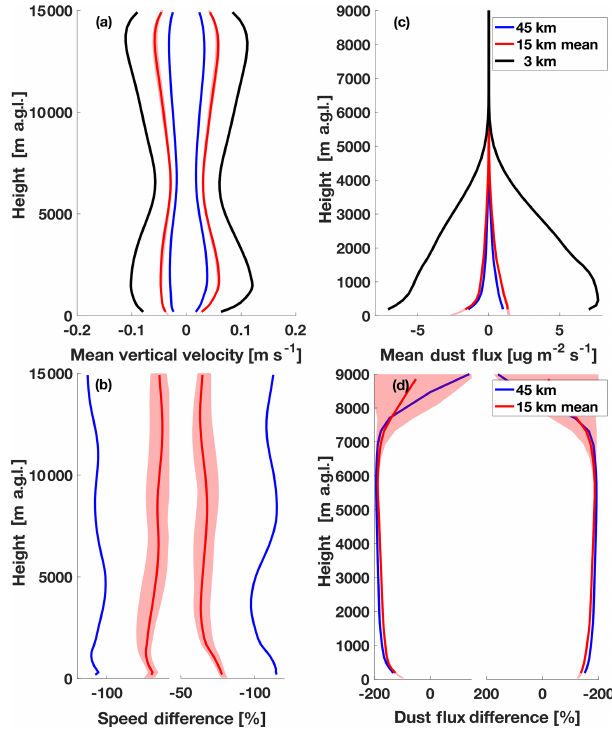
Figure 8. (a) Spatially and temporally averaged vertical velocities as well as (b) the percent difference between the 3km convection- permitting simulation and the simulations employing cumulus pa- rameterizations. All velocities above or below zero were consid- ered. Colors and shading are identical to those used previous figures. Panels (c) and (d) are the same as panels (a) and (b) but represent the vertical dust mass flux. Note that the vertical axes are truncated at 9km in panels (c) and (d) as the values above this height do not vary significantly from what is shown